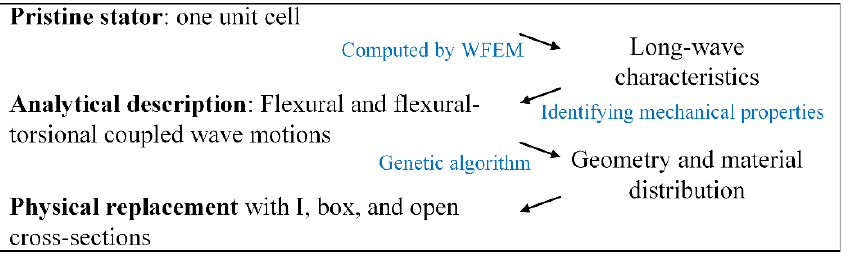
Figure 2. Technical route for homogenization.